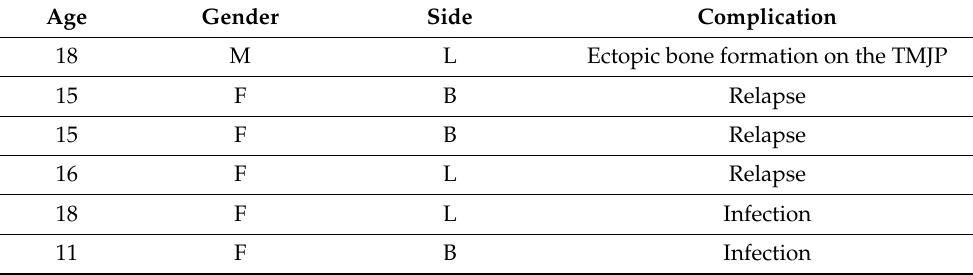
Table 4. Summary of complications associated with the treatment of the